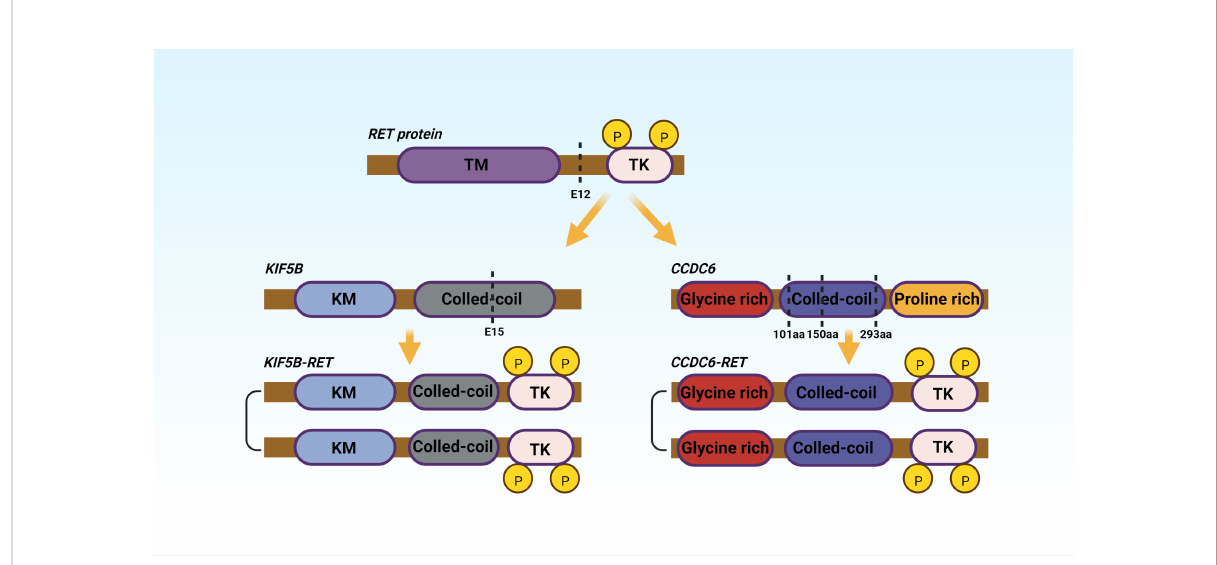
FIGURE 2 TM, Hydrophobic Transmembrane domain; TK, Tyrosine Kinase domian; KM, Kinesin motor; aa, amino acid. The fi gure shows the two most common fusions, KIF5B-RET and